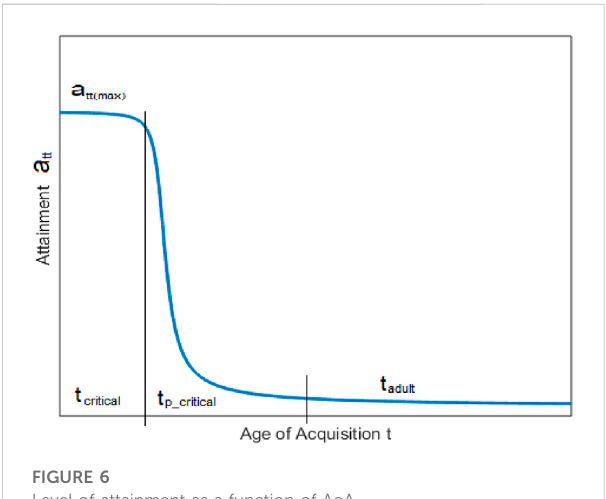
FIGURE 6 Level of attainment as a function of AoA. FIGURE 7